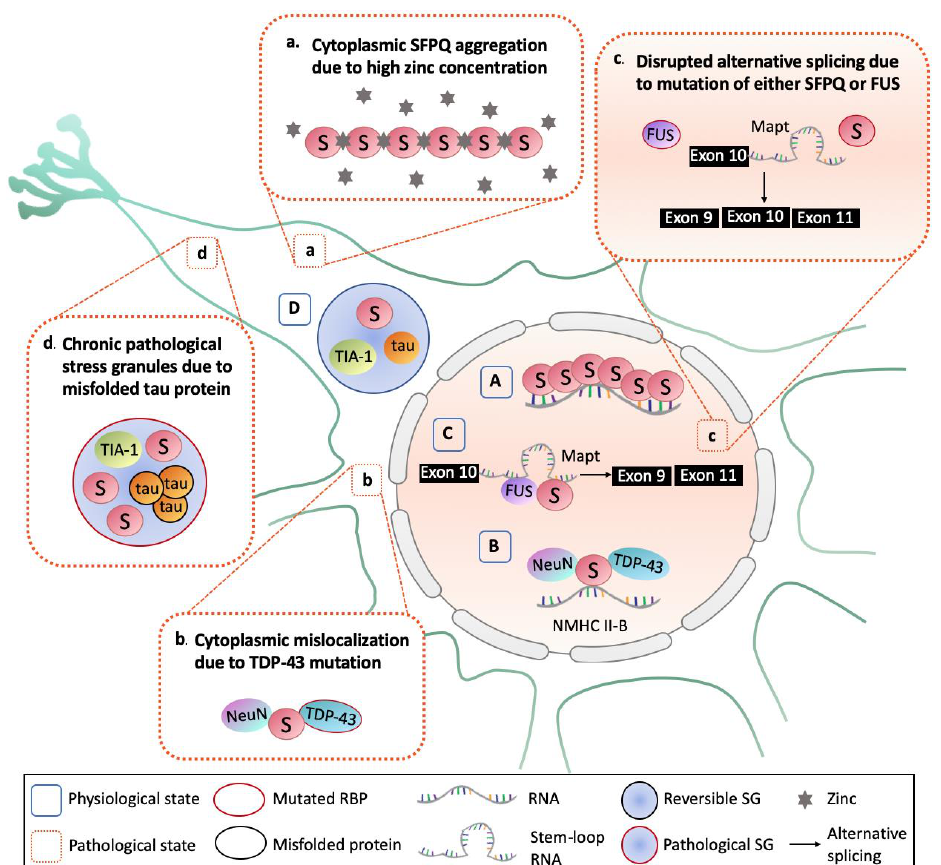
Figure 3. Schematic comparison of the neuronal functions of SFPQ in physiological conditions ( A – D ) with pathological features of SFPQ in the disease states ( a – d ). ( A ) SFPQ is critical for transcriptional elongation of long genes in the developing brain while the cytoplasmic aggregation and mislocalization of SFPQ are observed in many neurodegenerative diseases including, amyotrophic lateral sclerosis (ALS), frontotemporal lobar degeneration (FTLD), and Alzheimer’s disease (AD). One possible mechanism of cytoplasmic aggregation and mislocalization of SFPQ caused by high zinc concentration in the cytosol is shown ( a ). ( B ) The alternative splicing of the NMHC II-B mRNA by NeuN and SFPQ in supporting neuronal development is influenced by TDP-43 mutation causing cytoplasmic mislocalization in the disease state ( b ). ( C ) Alternative splicing of the Mapt gene to form different isoforms of tau, is mediated by SFPQ and FUS; altered splicing is caused by mutation of either of these two RBPs ( c ). ( D ) SFPQ, TIA-1, and tau form reversible stress granules (SGs) under stress, which become persistent and pathological SGs in the disease state ( d ). SFPQ is depicted as red circles labeled with “S”